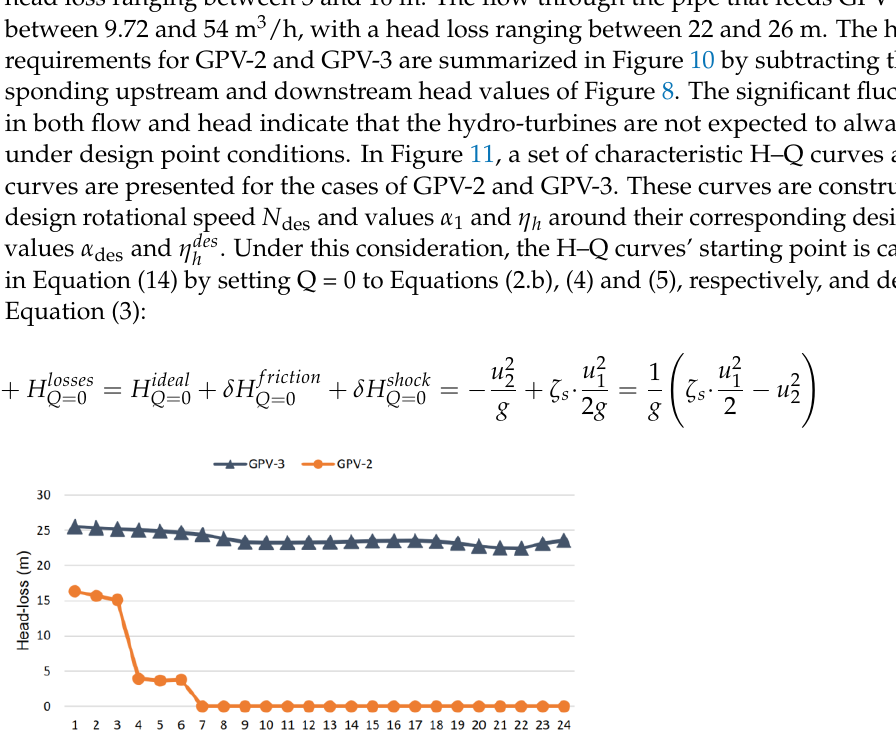
Figure 10 . GPV-2 and GPV-3 head loss requirements during their active time periods .